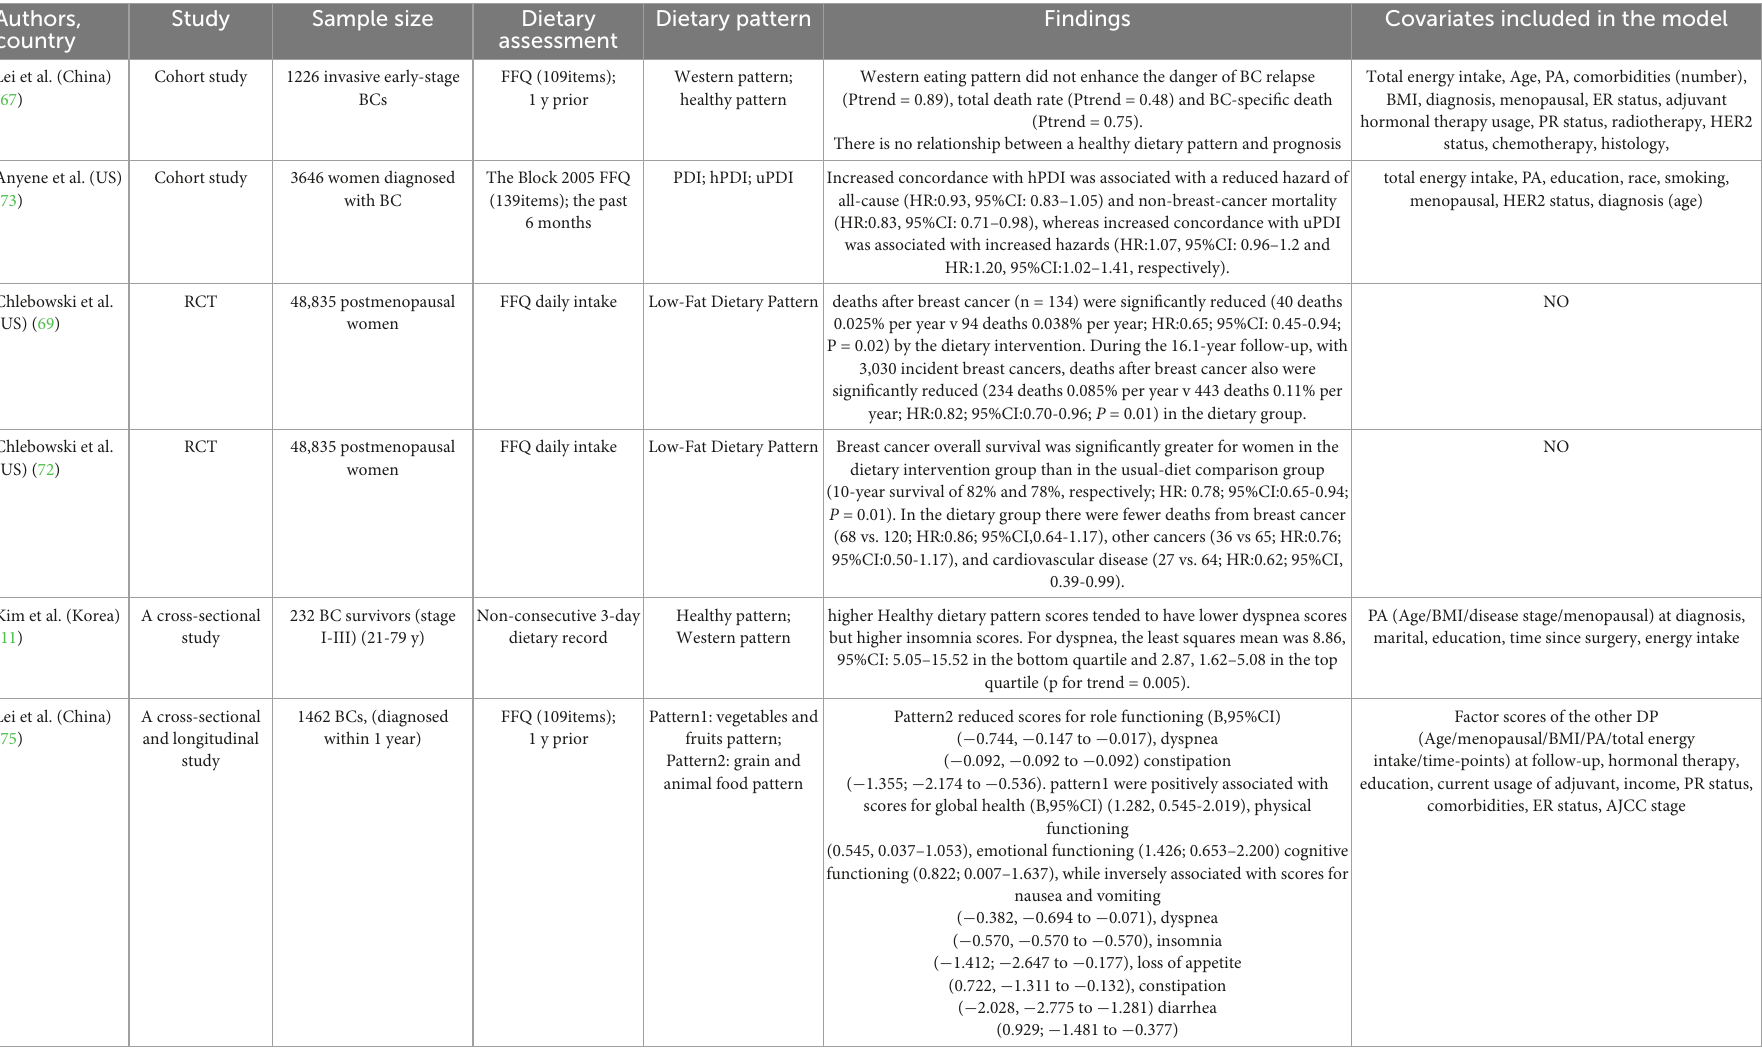
FFQisanabbreviationforfoodfrequencyquestionnaire;yisanabbreviationforyear;ORisanabbreviationforoddratio;CIisanabbreviationforConfidenceInterval;SQFFQisanabbreviationforSemi-QuantitativeFoodFrequencyQuestionnaire;HER2isanabbreviation for human epidermal growth factor receptor 2; HRT is an abbreviation for hormone replacement therapy; ER is an abbreviation for estrogen receptor; PR stands for progesterone receptor; CM is an abbreviation for Chinese medicine; DQX is an abbreviation for food frequencyquestionnaire;SESistheabbreviationofsocioeconomicstate;PAistheabbreviationofphysicalactivity;BBDstandsforBenignbreastdisease;OCPstandsfororalcontraceptive;QOLstandsforthequalityoflifeScore;AJCCisshortforAmericanJointCommittee on Cancer; DP stands for Dietary pattern; BMI stands for Body Mass Index; PHT is an abbreviation for postmenopausal hormone therapy; aMED is an abbreviation for alternate Mediterranean Diet; NSAIDs is an abbreviation for Non-steroidal Antiinflammatory Drugs; WHR is an abbreviation for Waist-to-Hip Ratio; HT is an abbreviation for hormone therapy; FFP is an abbreviation for parity and age at first full-term pregnancy; DASH is an abbreviation for Dietary Approaches to Stop Hypertension; PDI is an abbreviation for Plant